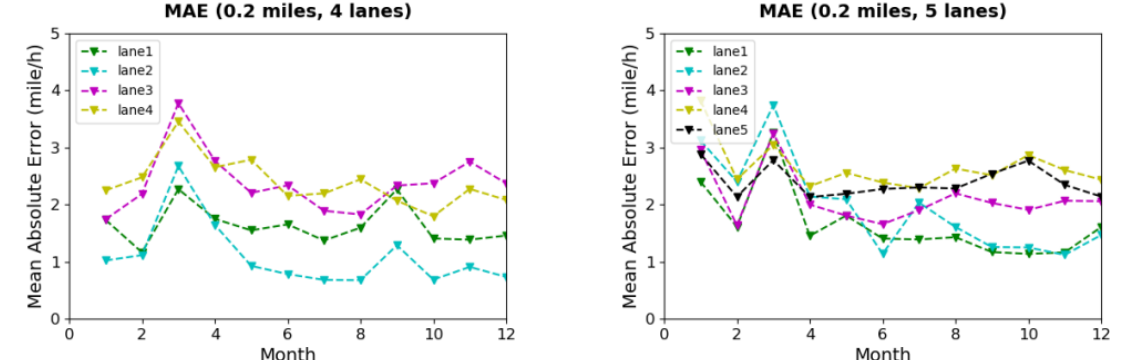
Figure 10. Segments where errors of different lanes are uncorrelated with lanes positions.